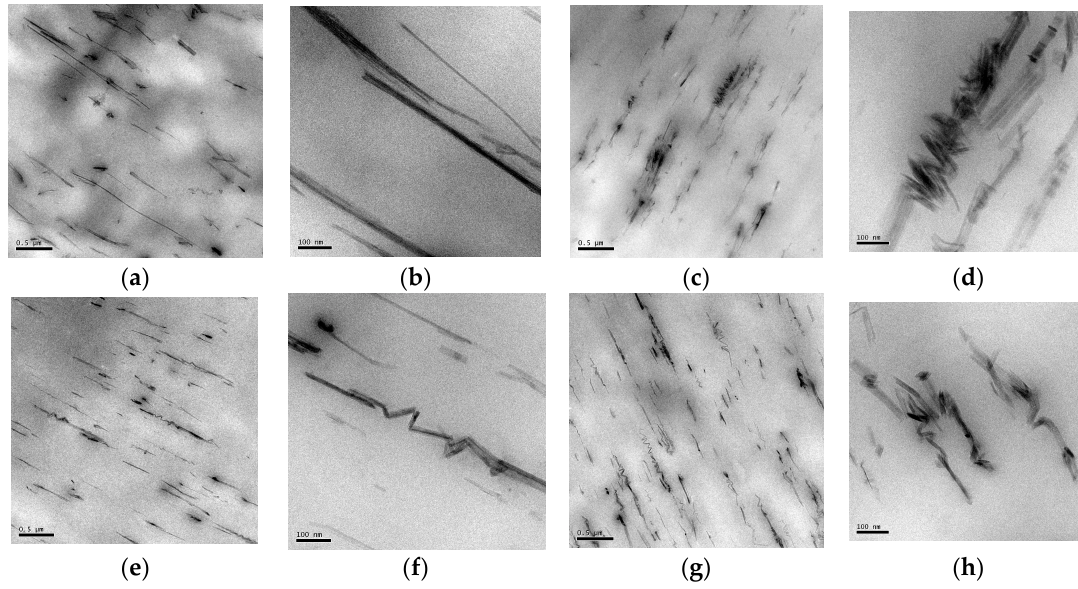
Figure 4. TEM images of samples of PCL + 2 wt% sep. ( a ) and ( b ) sample 3.1: undrawn sample, cooled with open chill rolls, ( c ) and ( d ) sample 3.3: drawn samples cooled with open chill rolls, ( e ) and ( f ) sample 4.1: undrawn sample cooled with closed chill rolls, and ( g ) and ( h ) sample 4.3: drawn samples cooled with open chill rolls. The white line in the pictures indicates the extrusion direction.